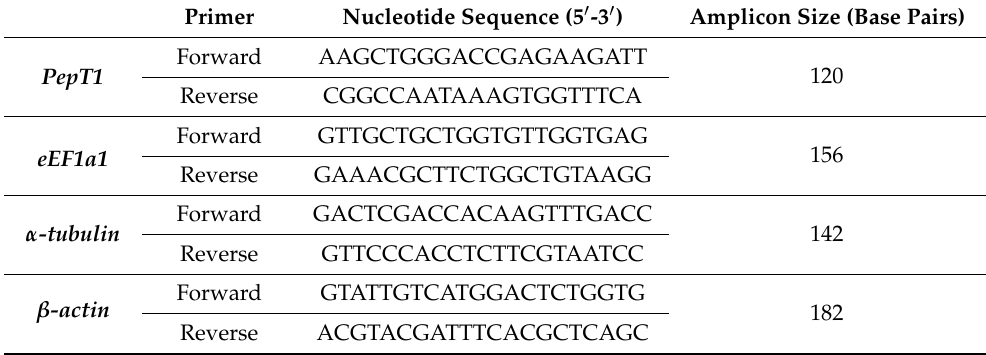
Table 3. Primers used to amplify target